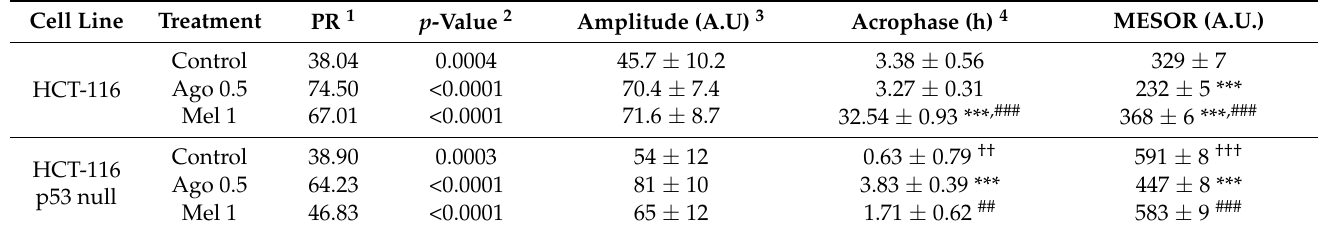
Table 4. Results of the cosinor analysis of PEX1-gene expression after agomelatine or melatonin treatment in the HCT-116 and HCT-116-p53-null cell